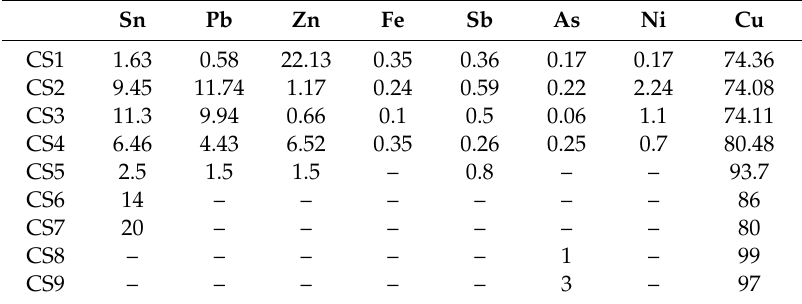
Table 1. Reference calibration samples for quantitative analysis (element concentration in weight percentage,